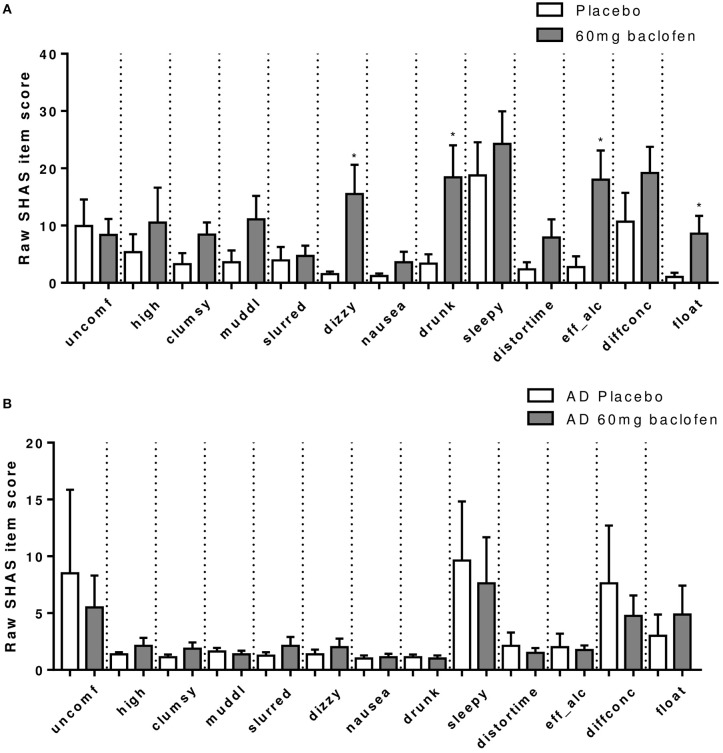
Effect of baclofen on SHAS subscores in (A) controls (n = 12) and (B) AD (n = 8) after 60 mg baclofen. Data are mean ± S.E.M. and represent the raw scores which are a breakdown of total SHAS items at 120 min post administration of 60 mg baclofen. The SHAS consists of 13 items scored 0–100. These items are “uncomfortable,” “high,” “clumsy,” “muddled,” “slurred speech,” “dizzy,” “nauseated,” “drunk,” “sleepy,” “distorted sense of time,” “effects of alcohol,” “difficulty concentrating,” and “feeling of floating”. *60 mg > placebo (P < 0.05).